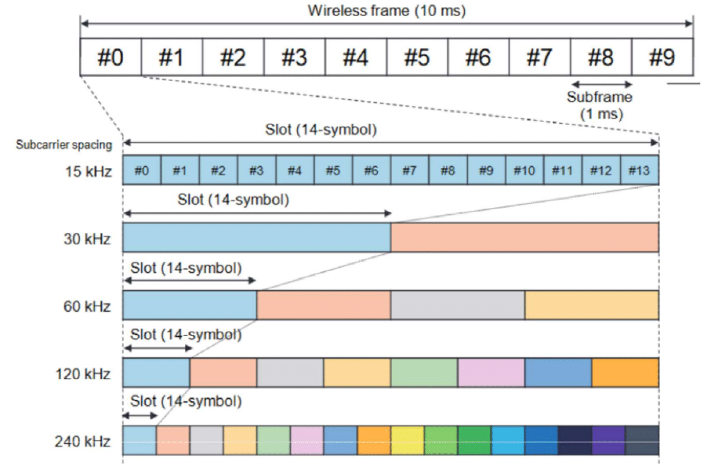
Figure 3. The diagram of the frame structure of 5G/B5G NR for different OFDM numerologies [8].